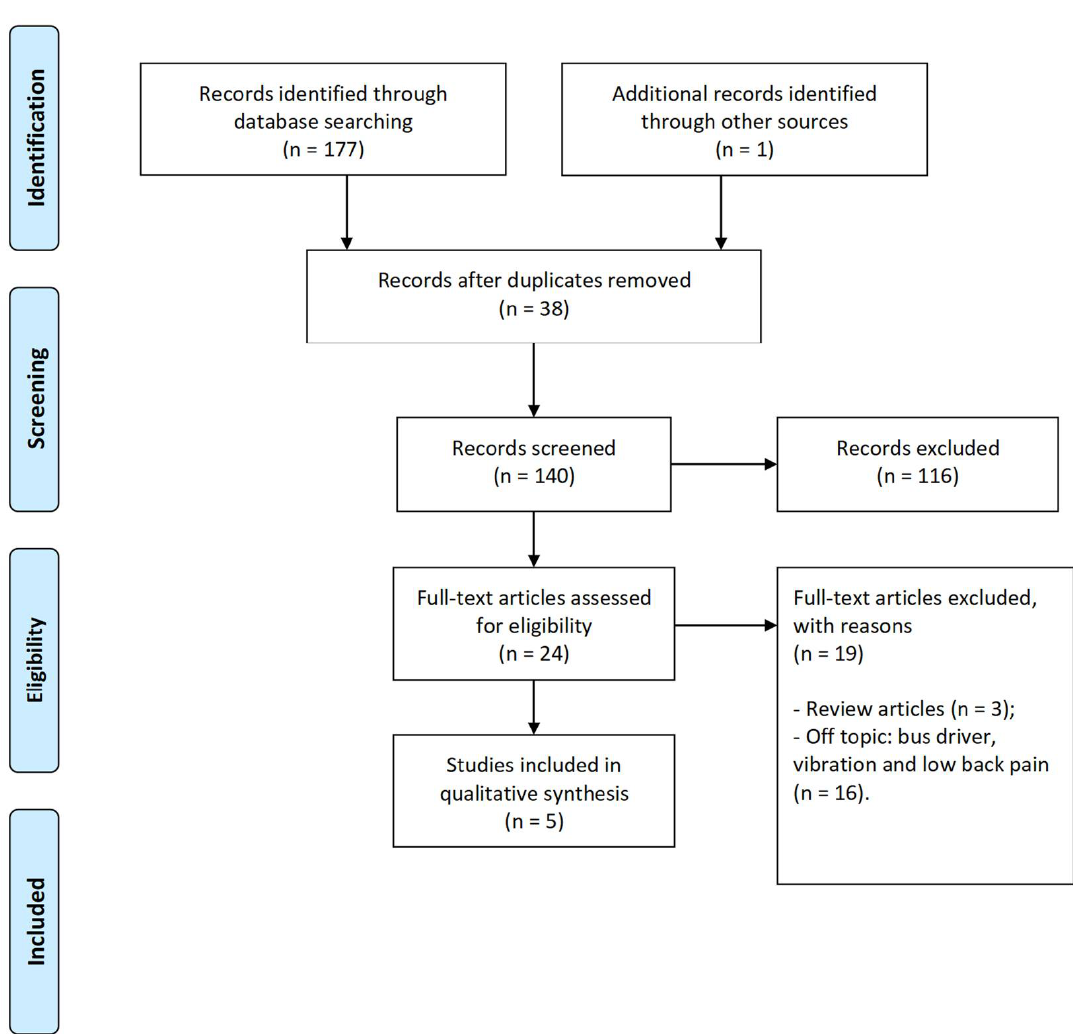
Figure 1. PRISMA flow diagram of the literature selection process.